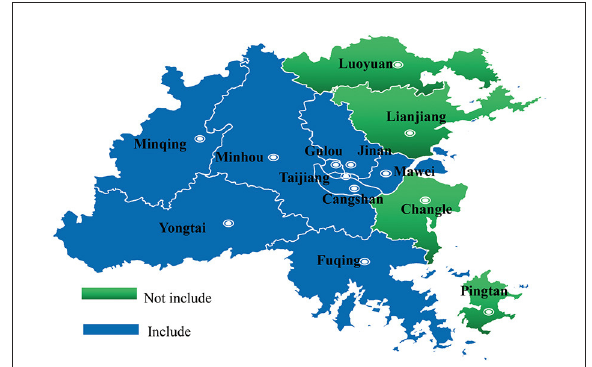
FIGURE1 Districts selected in Fuzhou. List of schools: 18 primary schools and 18 middle schools were randomly chosen from 9 selected Districts. Specific list: Yanan Middle School, Yangqiao Middle School, No.2 Primary School, Huaqiao Primary School